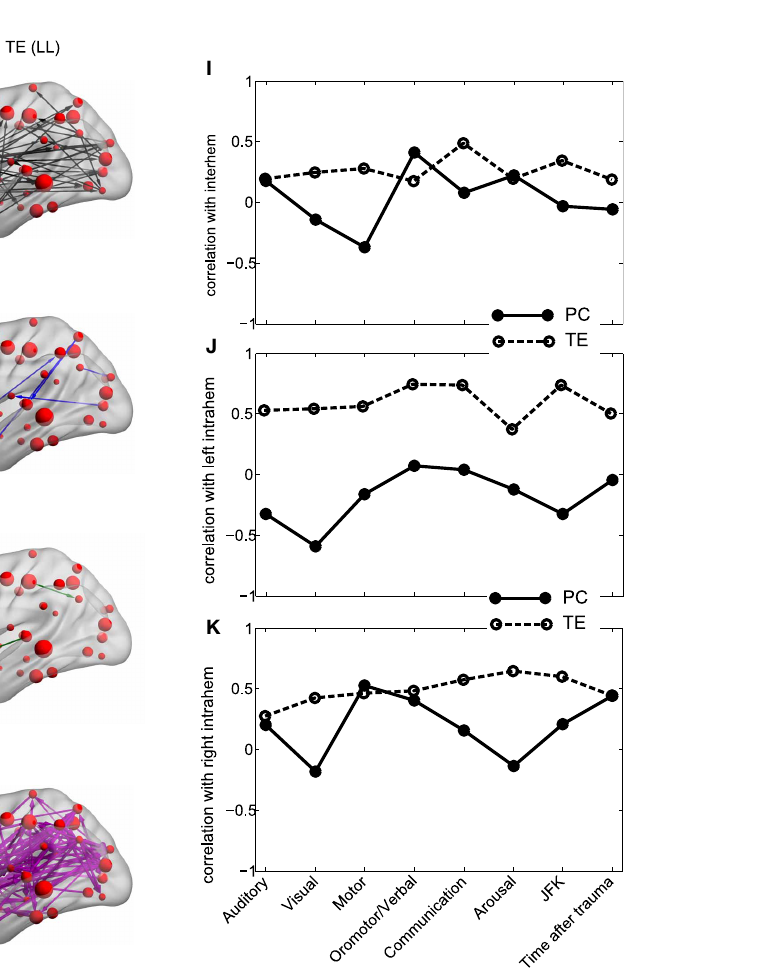
FIGURE 4 | Inter-hemispheric PC and left intra-hemispheric TE. (A–H) PC and TE values for all the 4 different groups. The thickness of links and arrows are proportional to the PC and TE values; the thickness normalization factor is common among all the 4 groups. (A,E) group G1, black, (B,F) group G2, blue, (C,G) group G2a, green, (D,H) group G2b, magenta. (A–D) Visualization of the PC values HIH (homologue inter-hemispheric pairs). (E–H) TE in LL (left intra-hemispheric pairs). For clarity in the visualization, links have been thresholded and only TE